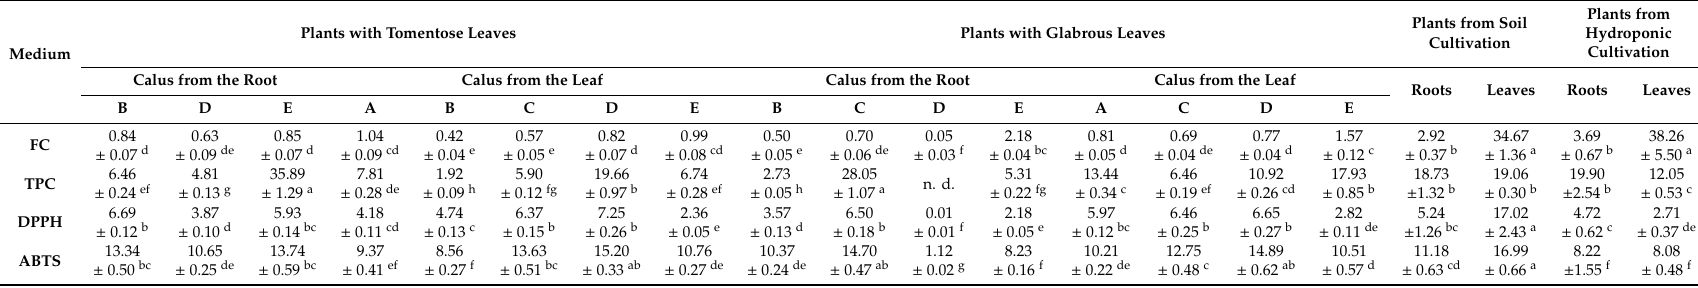
Table 2. Flavonoid content and antioxidant activity (mg · g − 1 dry plant material ± SE) in extracts from the investigated plant materials ( n = 3).